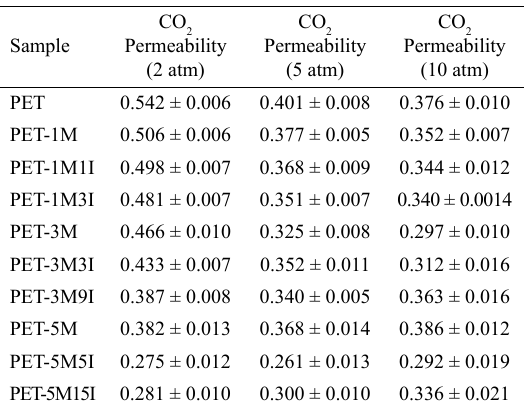
permeability of PET and PET/o-Mt nanocomposites Table 4. CO 2 at different upstream pressures.